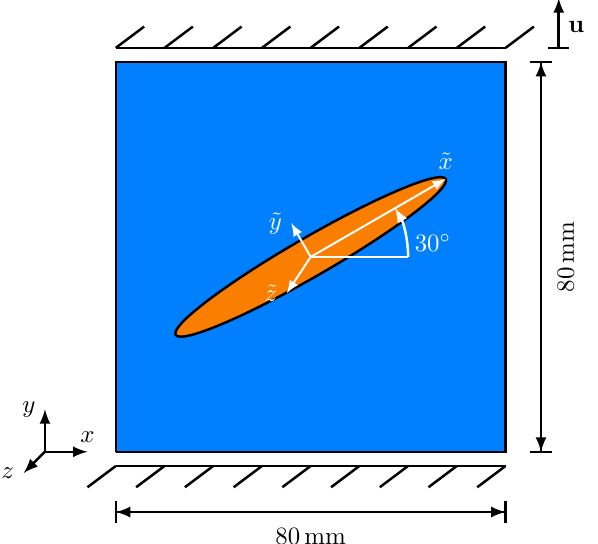
Figure 5. Setup of the crack development investigation in a domain consisting of an elliptic, trans- versely isotropic brittle inclusion, embedded in a ductile matrix, accompanied by the mechanical boundary conditions. The ductile matrix is represented in blue, while the brittle inclusion phase is represented in